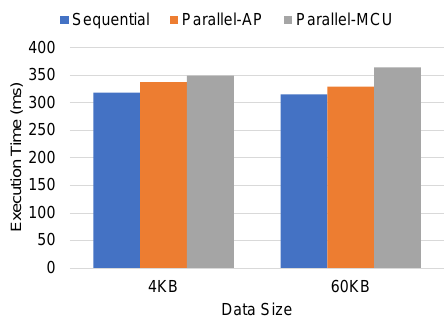
Figure 7. Single-page data verification time.